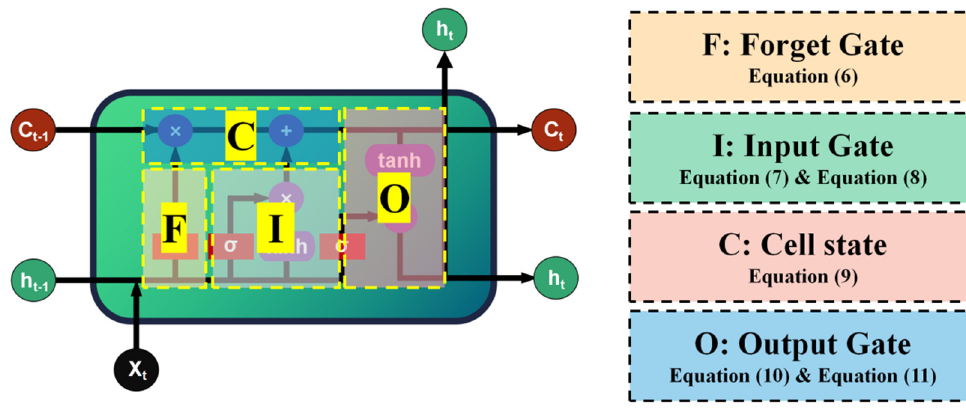
Figure 3. The original model structure and calculation formula of LSTM. DNN is a multilayer feedforward network trained by error back-propagation. It takes the square of the network error as the cost function and uses the gradient descent method to calculate the minimum value of the cost function. The DNN model used in this study, which is presented in Figure 4, consists of five layers: an input layer, three hidden layers, and an output layer. Since there was no accurate rule to determine the number of neurons in the hidden layer, it was generally determined by repeated trial and error. After constantly trying different numbers of neurons during the operation of the model, the number was finally determined to be 41. The input layer consisted of 15 neurons, the number of neurons in the three hidden layers were 10, 10, and 5, and the output layer was